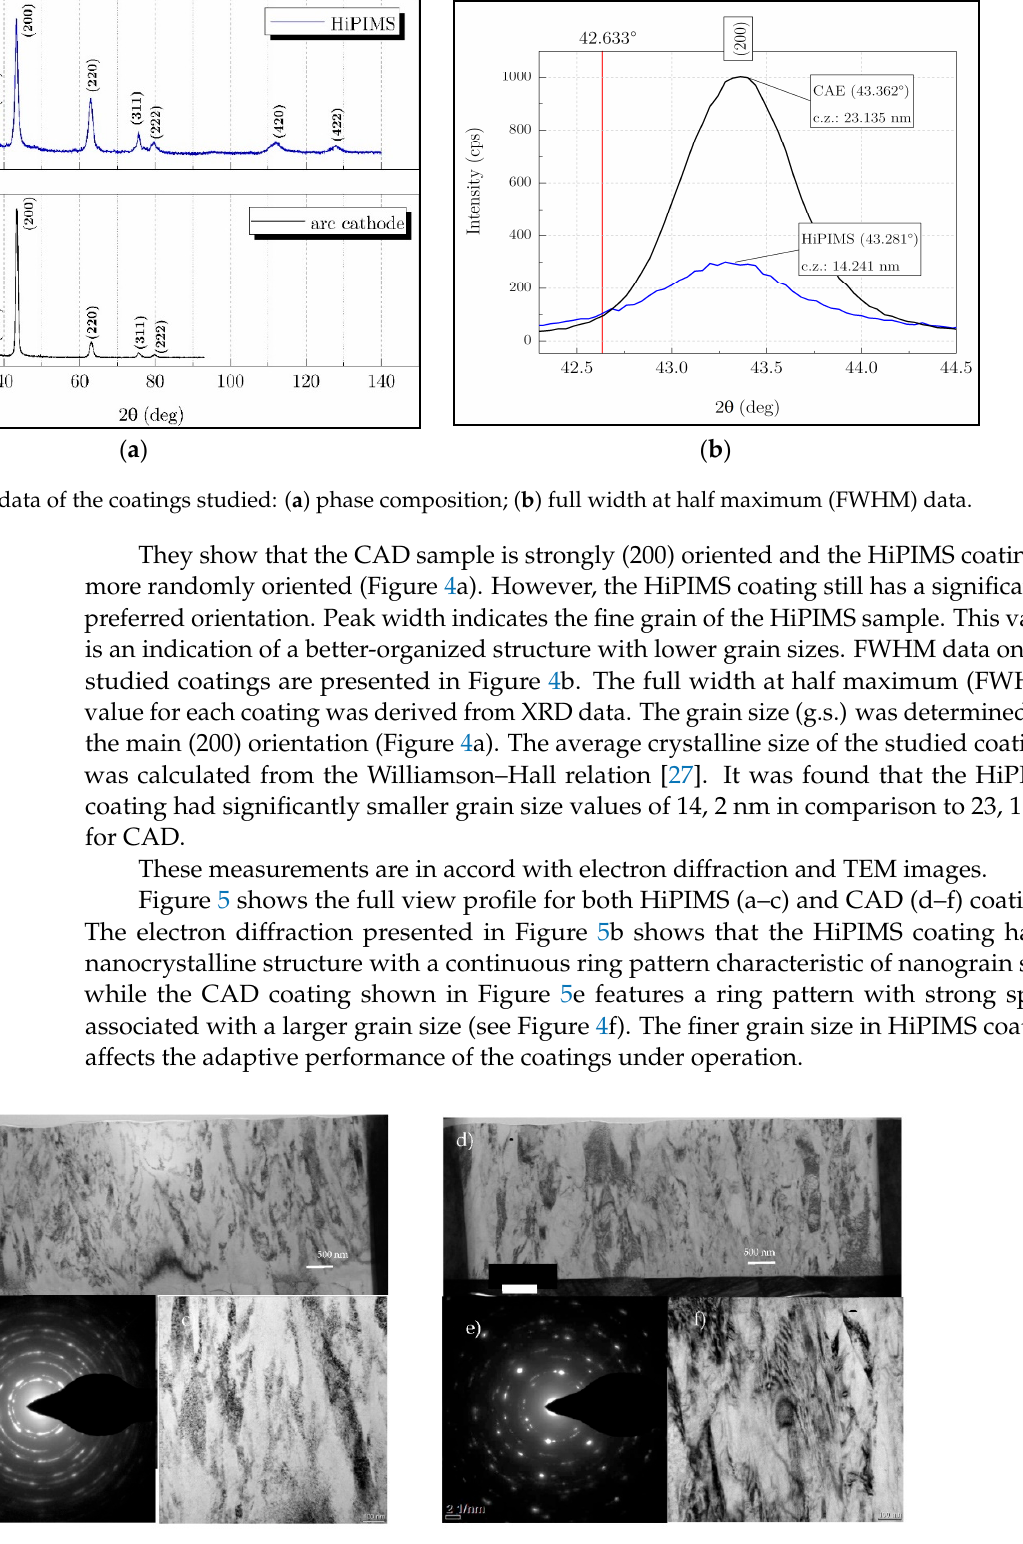
Table 2. Porosity values of the studied coatings.